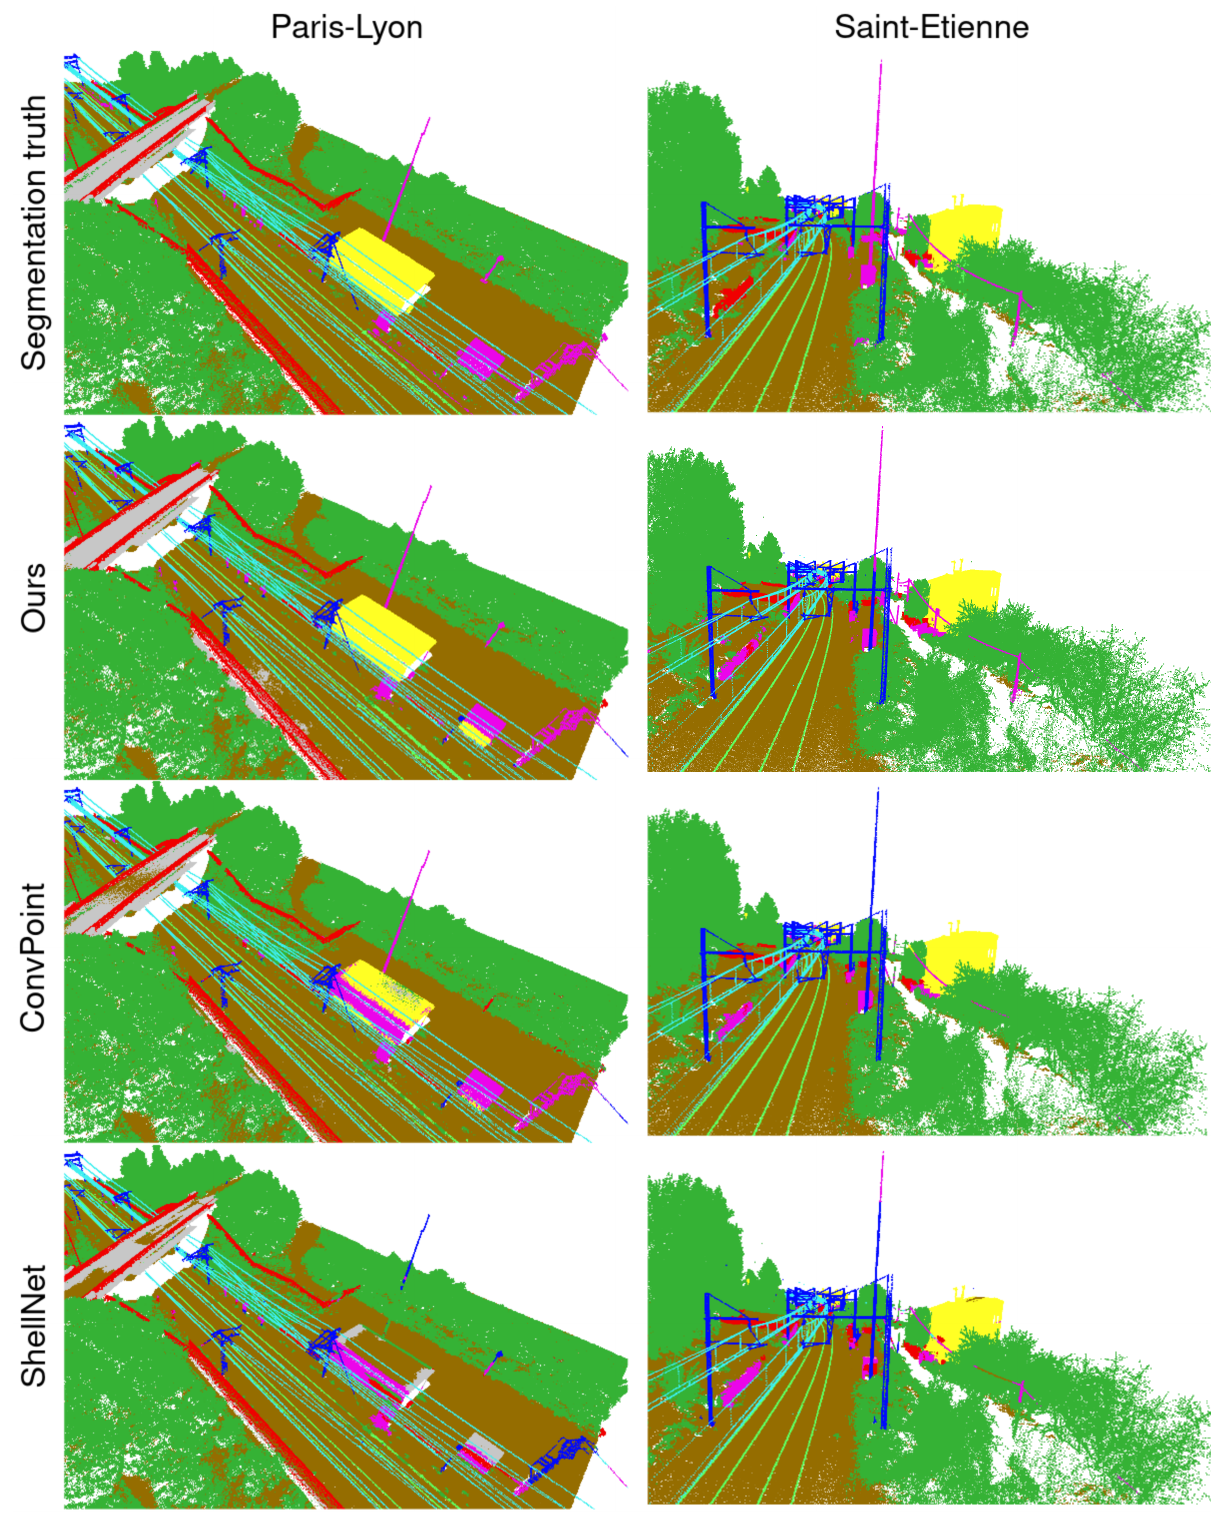
Figure 7. Colorized segmentation results on both railway datasets with: Ground in brown, Rail in bright green, V egetation in plain green, Fence in red, Building in yellow, CatenaryPole in blue, CatenaryWire in cyan, Structures in grey, Environment in bright